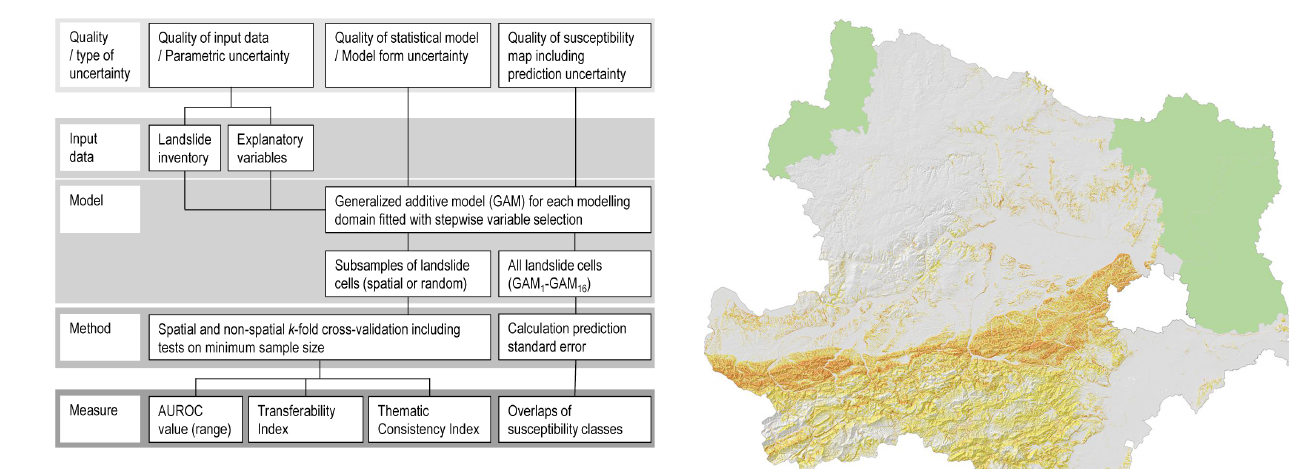
Fig. 3. Flow chart presenting the methods and measures applied Figure 3. Flow chart presenting the methods and measures applied within this study assessing 2 within this study assessing the quality of input data, quality of sta- the quality of input data, quality of statistical model and quality of final susceptibility map. 3 tistical model and quality of final susceptibility map.